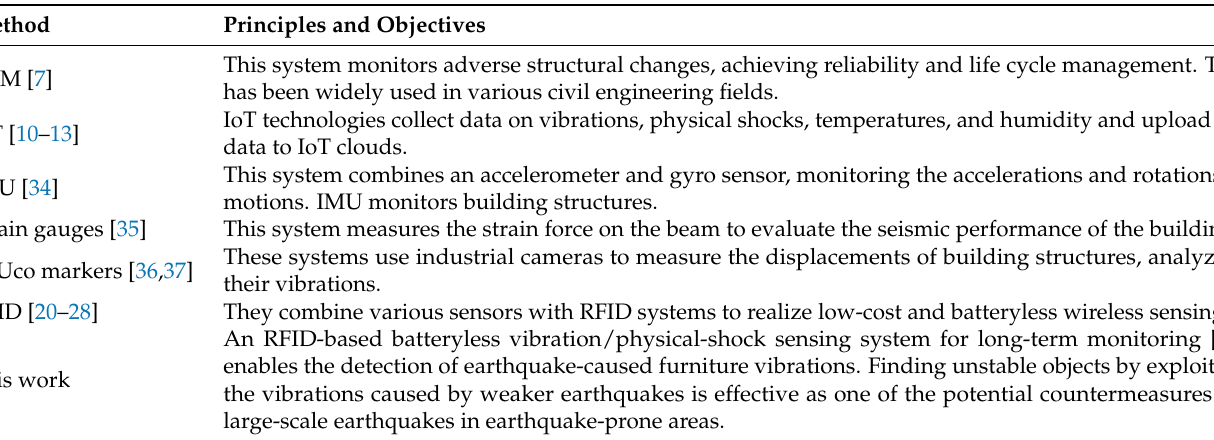
Figure 1. Application example for an earthquake-caused vibration monitoring system in a home. Table 1. Comparison of the environmental observation